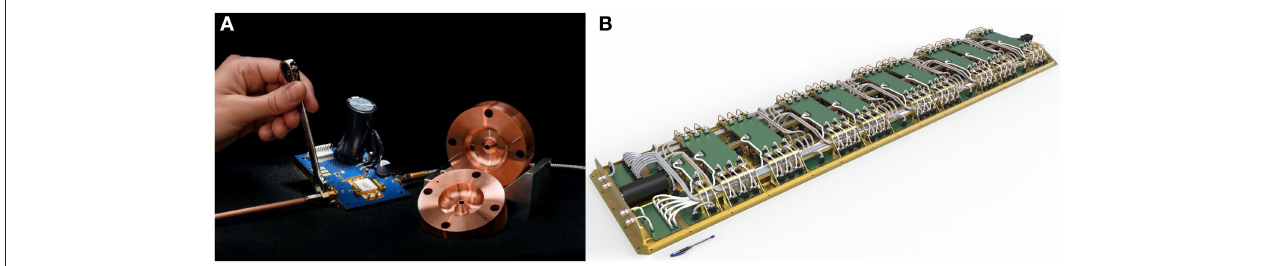
FIGURE 2 | (A) Photo of two halves of a C-band cavity and an HEMT on a printed circuit board; (B) A compact 55-cavity, 1.7-m long, 1-MeV electron accelerator based on HEMT solid-state RF